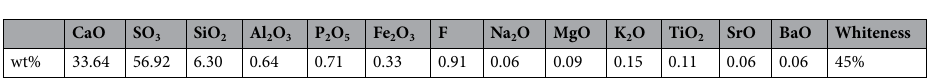
Table 1. Chemical composition and whiteness of